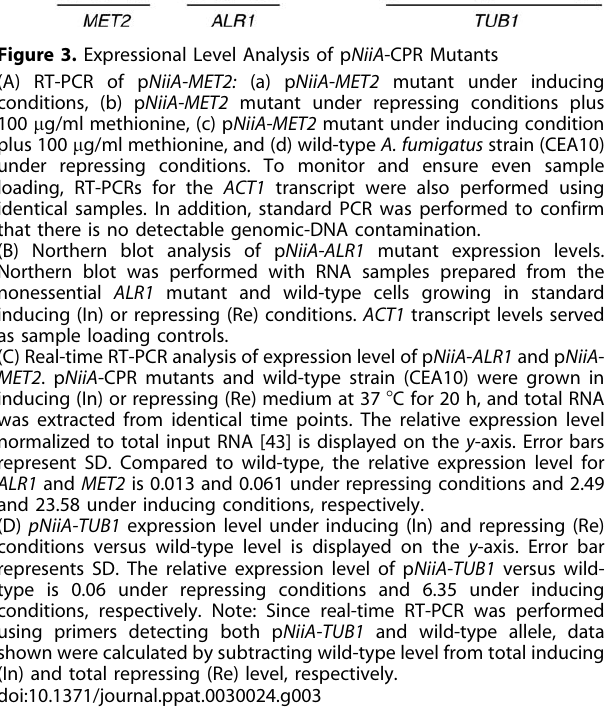
(B) Northern blot analysis of p NiiA - ALR1 mutant expression levels. Northern blot was performed with RNA samples prepared from